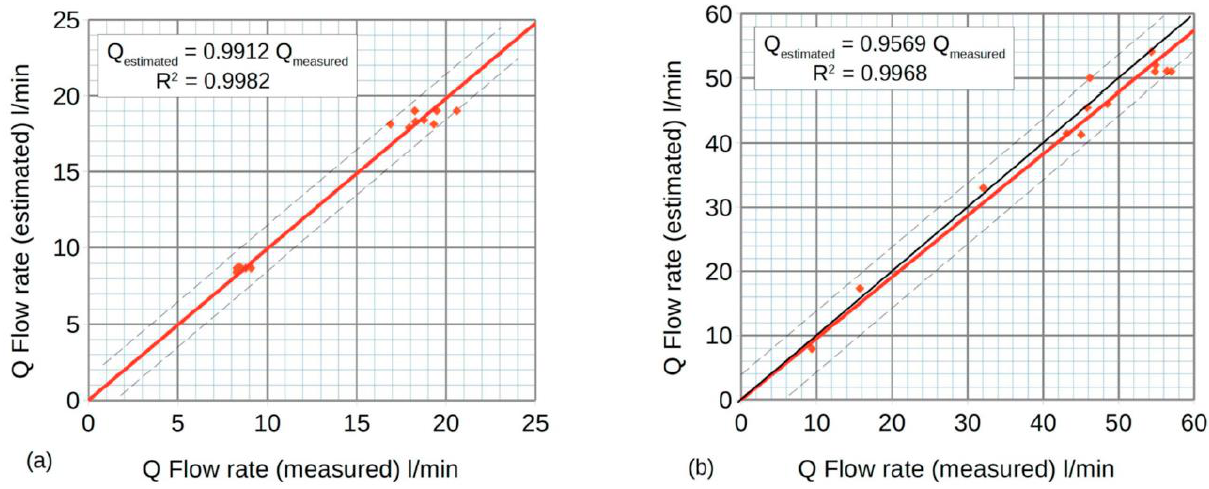
Figure 14. Comparative graphs between measured and estimated flows (Q S ) for the two machines: 14 ( a ) machine M 1 and 14 ( b ) machine M 2 .